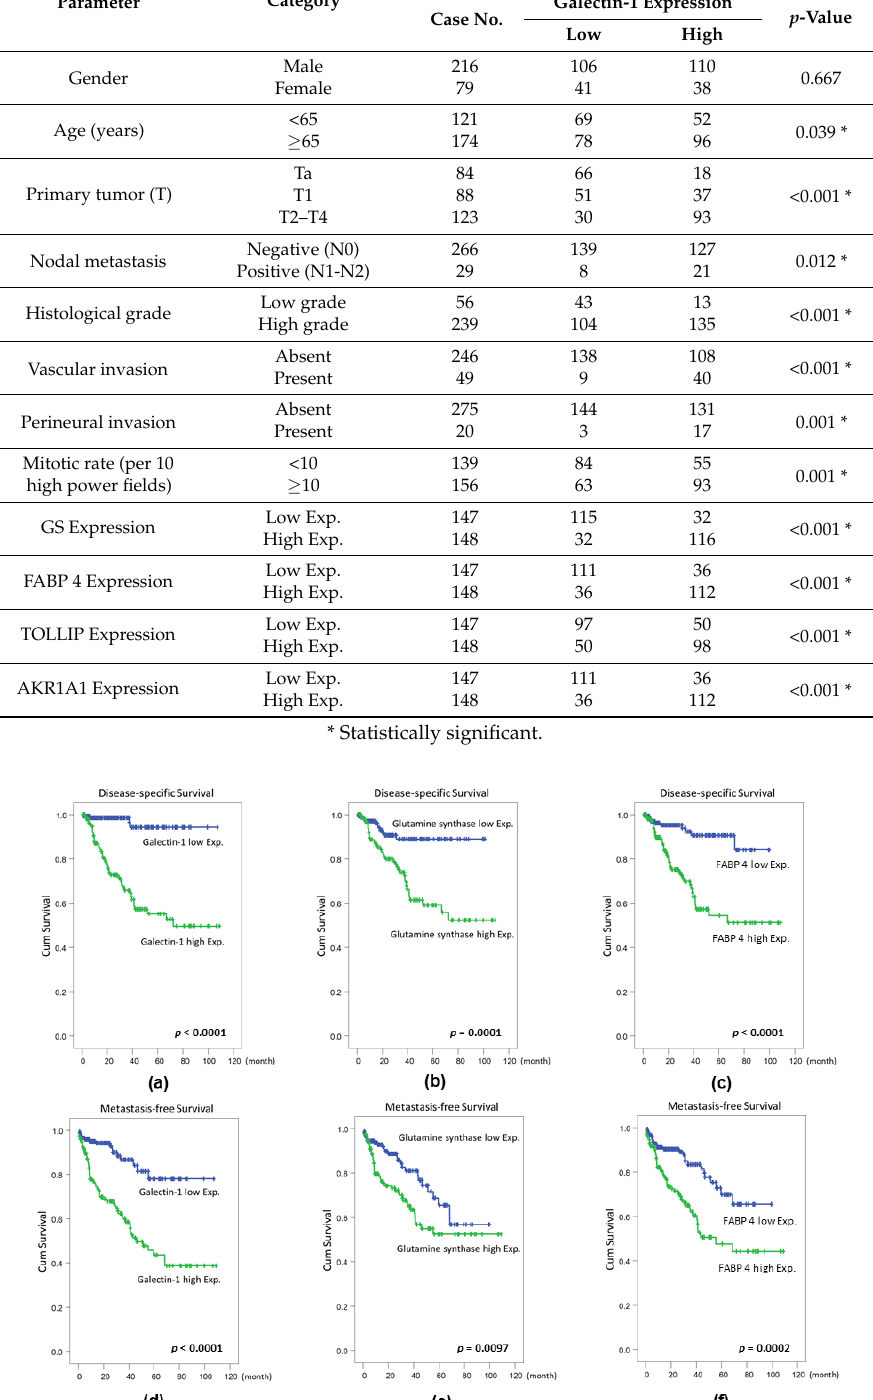
Table 2. Correlations between Galectin-1 Expression and other important clinicopathological, parameters in UBUC.